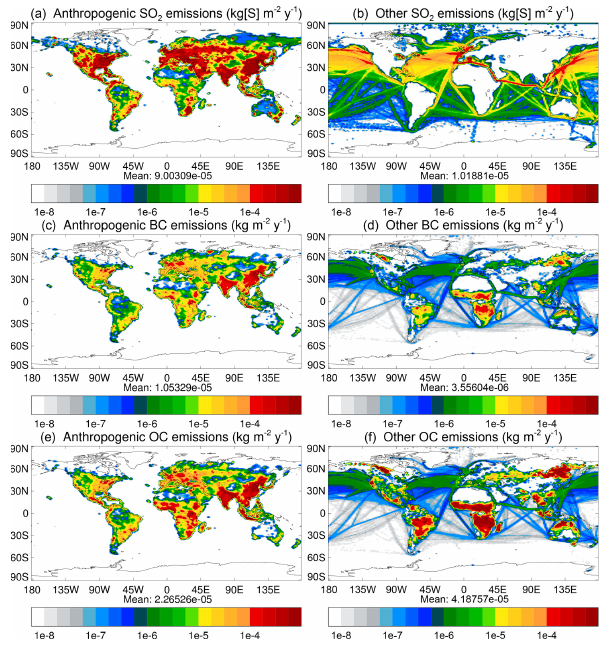
Figure 1. Emissions of aerosol and aerosol precursor species. (a, b) SO 2 ; (c, d) BC; and (e, f) OC emissions. Left column: ECLIPSE V4.0a anthropogenic emissions, which are perturbed in the re- spective experiments. Right column: natural, non-anthropogenic biomass burning (for the year 2008) and shipping emissions, which are not perturbed in these experiments.